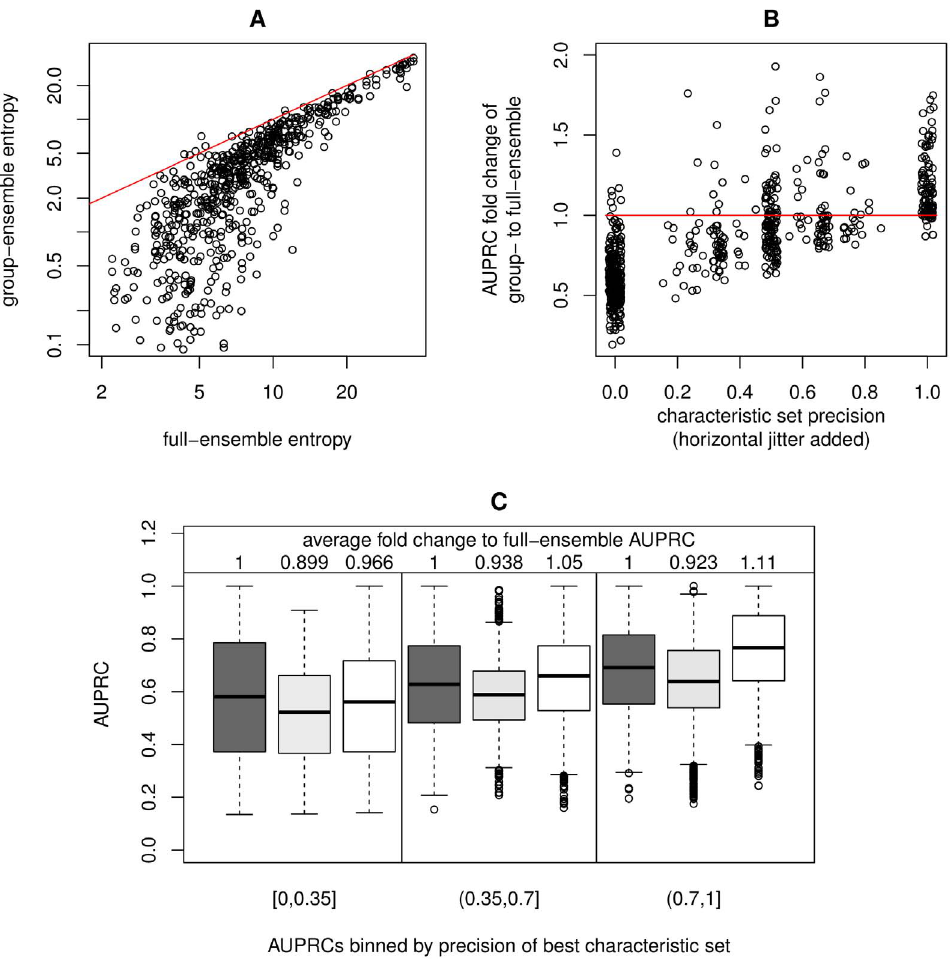
Figure 4. Entropy and AUPRC evaluation results. (A) The entropy of group-ensembles is on average decreased to 45% as compared to the entropy of the ensemble of all networks (full-ensemble). This is caused by the reduced fraction of low confidence interactions. (B) AUPRCs of group- ensembles are increased if their characteristic sets are present in the reference. Characteristic set precision ranges between 1 (all interactions are present in the reference) and 0 (no interaction is present in the reference). A small amount of horizontal jitter ( , 0.02) was added to the precision values for better visualization. The red lines indicate identity. (C) Rejecting alternative hypothesis by testing for the presence of characteristic set interactions (white boxplots) in general increases AUPRC, while testing for other low confidence interactions (gray boxplots) has a less pronounced or even negative effect. Thus, interactions that are predicted to be co-occurring with other interactions are preferred targets of further experimental verification. The full-ensemble AUPRC distributions are shown as dark-gray